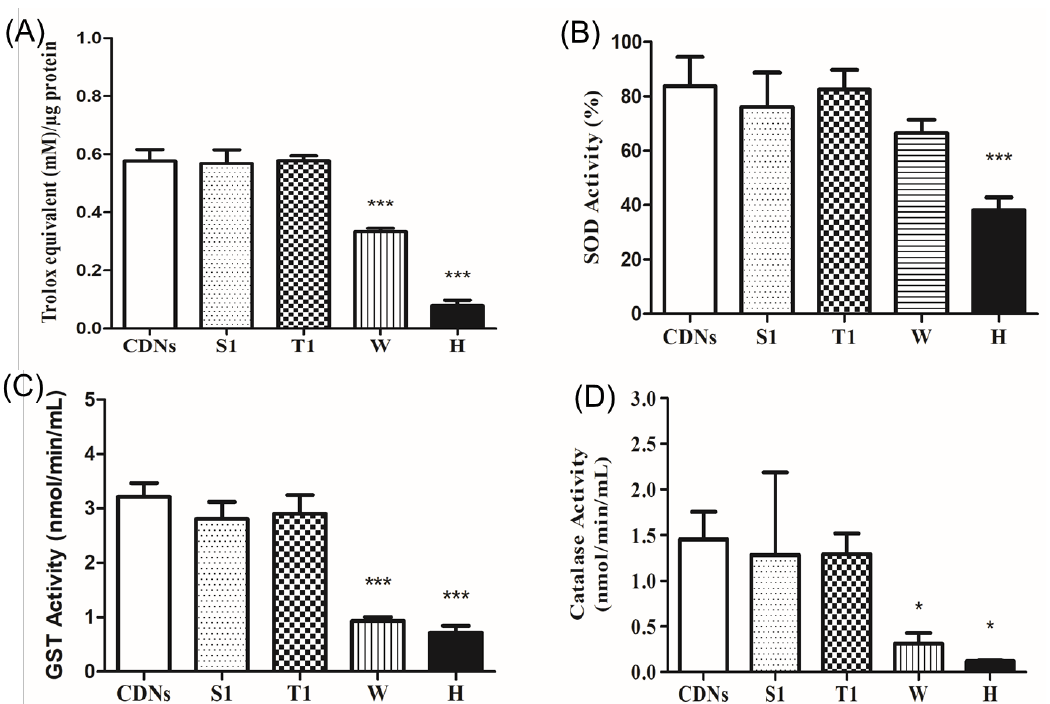
Figure 4. Antioxidant capacity of fresh CDNs and lyophilized CDNs. ( A ) Total antioxidant capacity was expressed as Trolox equivalent (mM)/ µ g of protein. ( B – D ) Antioxidant activities of SOD ( B ), GST ( C ), and catalase ( D ) were measured for fresh CDNs and lyophilized CDNs. * p < 0.05, *** p < 0.001, compared with fresh CDNs. Data represent mean ± SD ( n = 3).